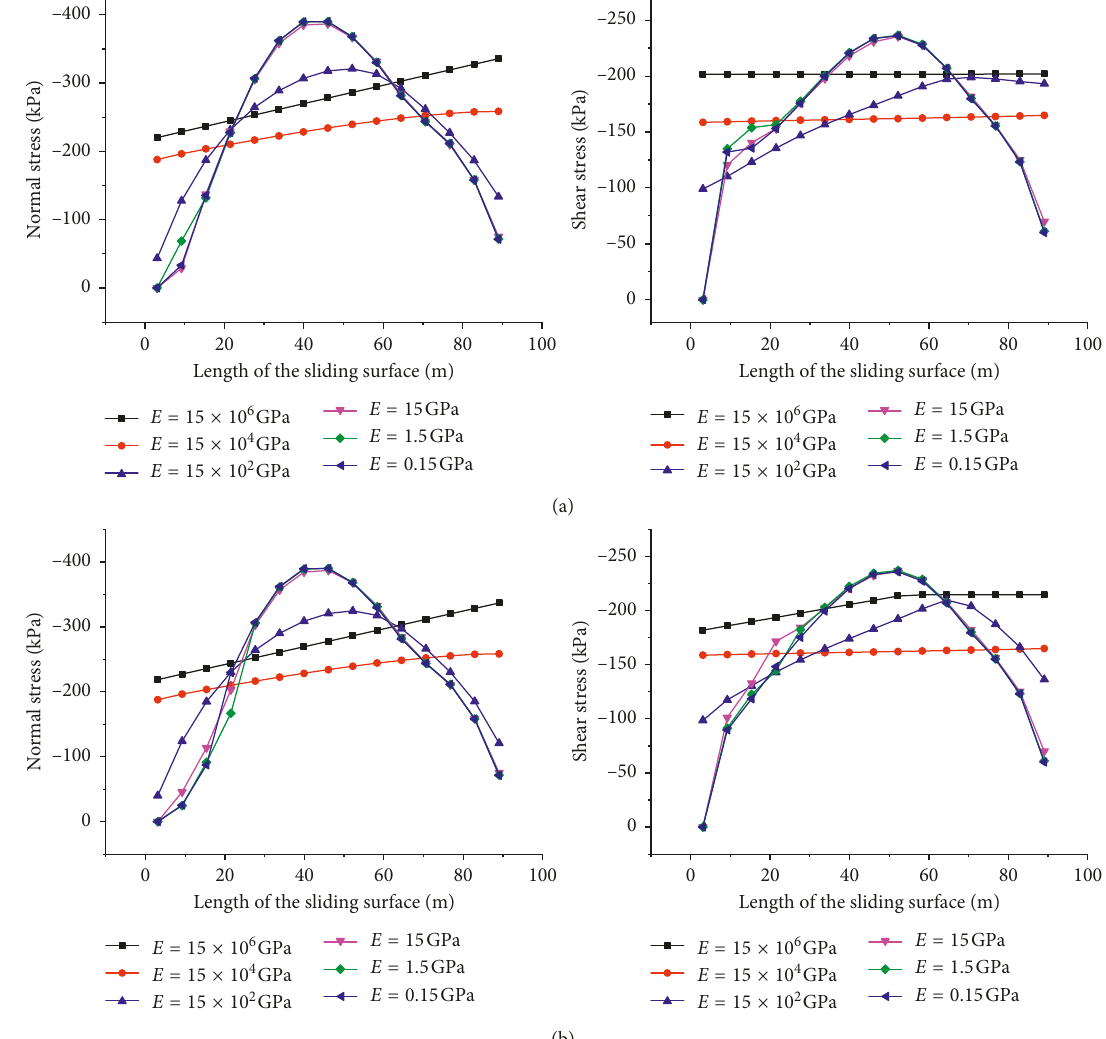
Figure 7: Effect of sliding body elastic modulus on stress distribution of the sliding surface: normal and shear stresses on the sliding surface of stable slopes (a) and unstable slopes